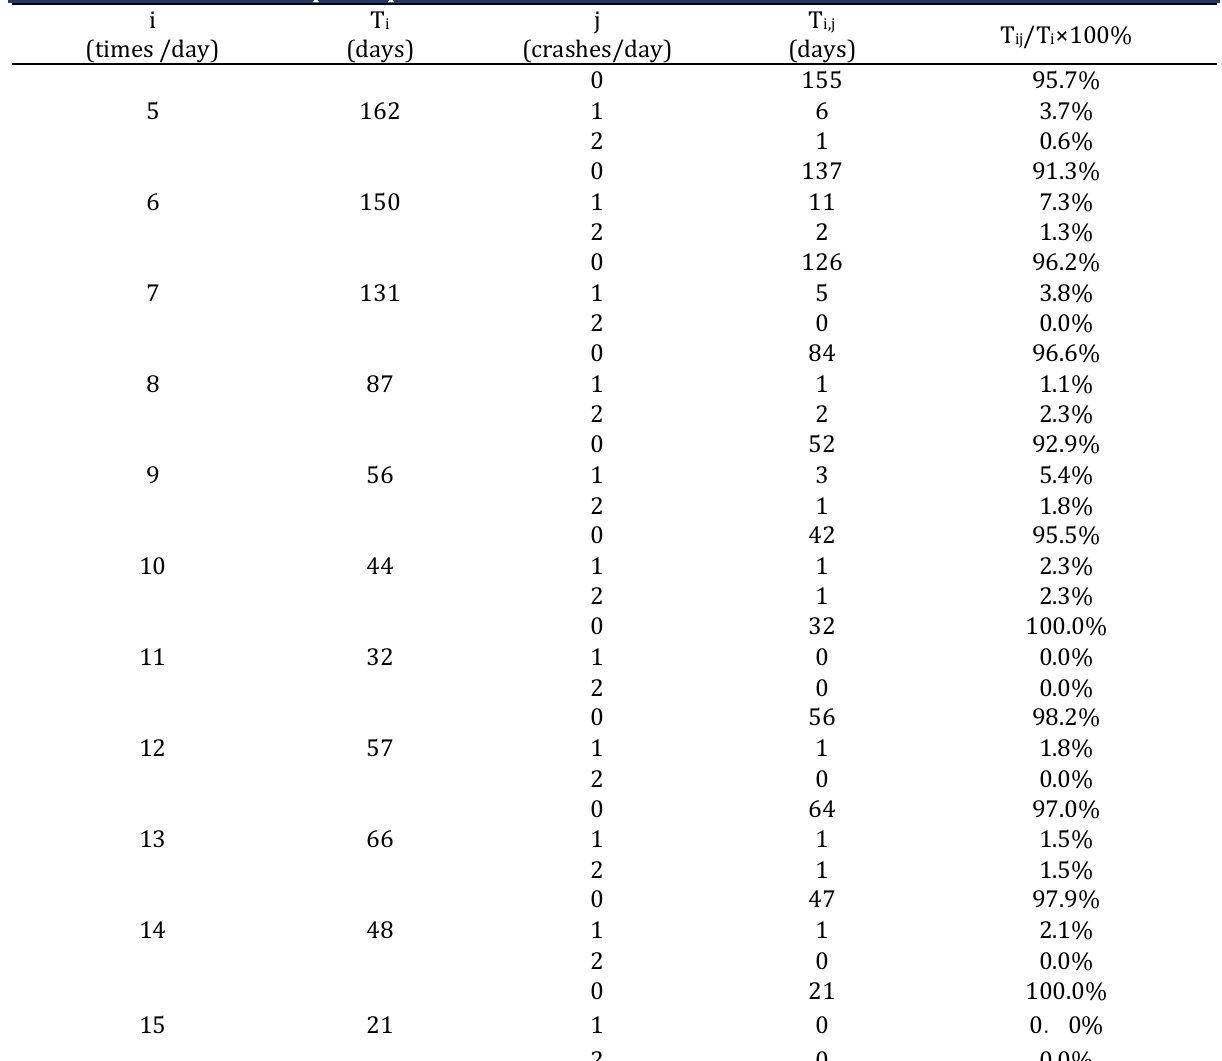
Table 3: Records of traffic police patrol and road crashes i (times